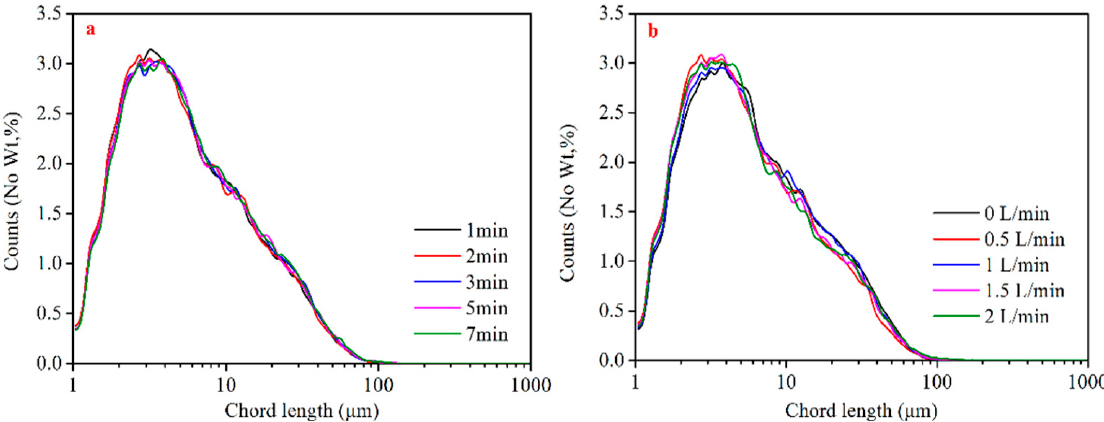
Figure 8. Size distribution of BMBs prepared under different conditions: ( a ) 0.5 L/min aeration rate, ( b ) 2 min preparation time.